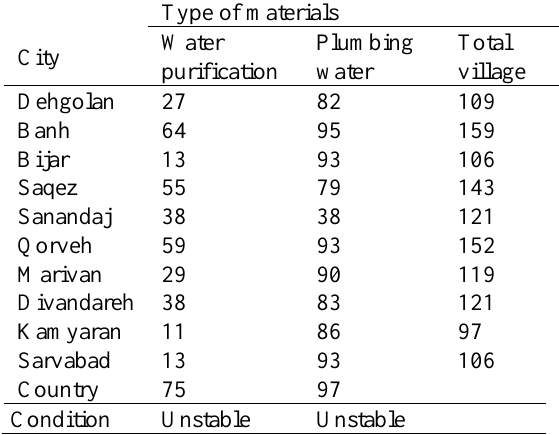
Table 7. Access to safe water in villages of